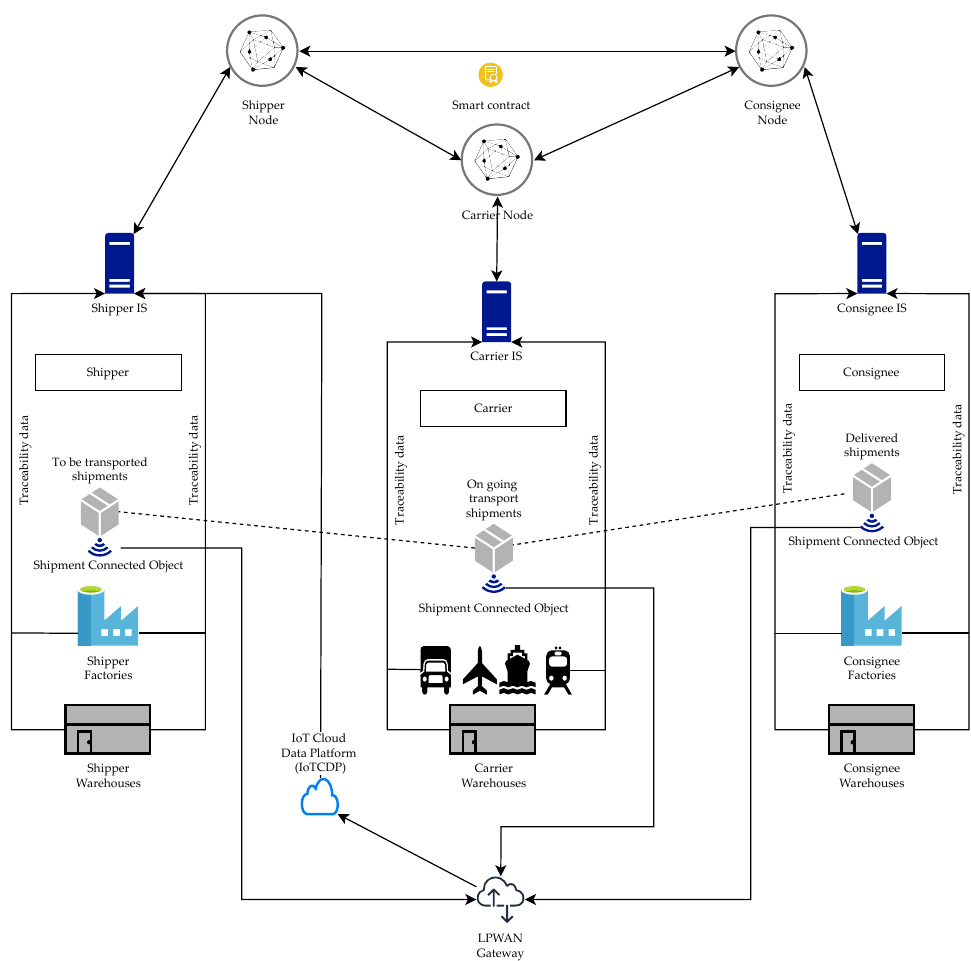
Figure 2. Distributed architecture of the traceability